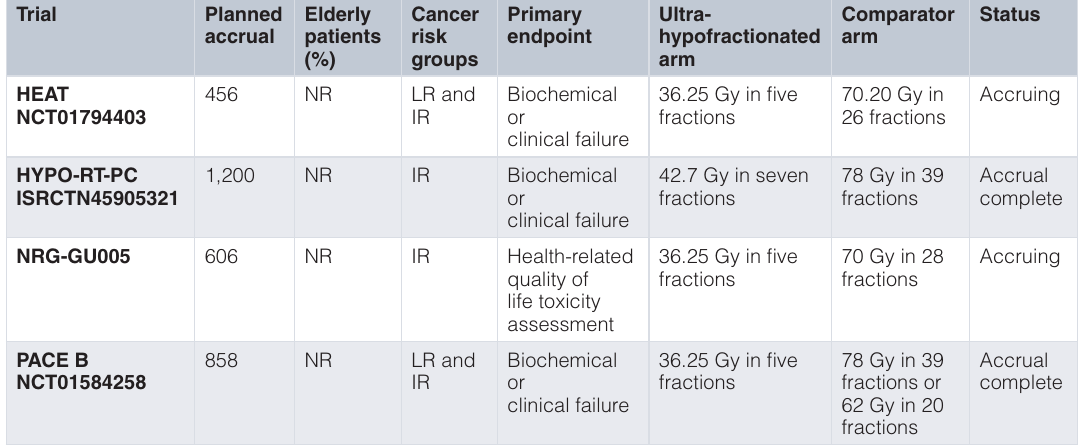
Table 3. Randomized trials evaluating ultra-hypofractionated external beam radiotherapy in prostate cancer.